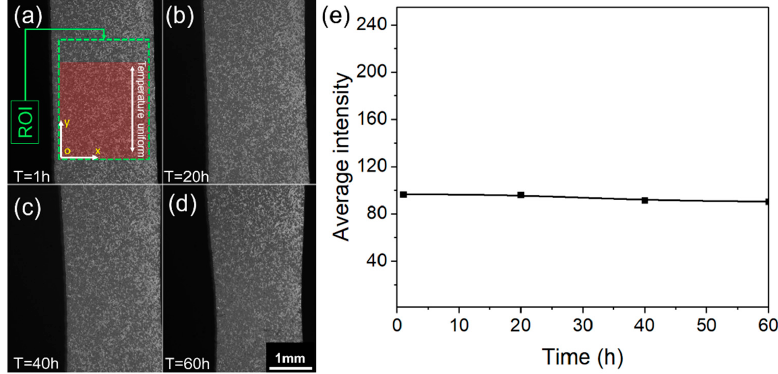
Figure 4. The typical DIC calculation image of the TW specimens at 1 h ( a ), 20 h ( b ), 40 h ( c ) and 60 h ( d ) during the creep test; ( e ) the average intensity of region of interest (ROI) at 1, 20, 40 and 60 h. The ROI was defined as surrounded by the green line in Figure 4a on the speckled surface. The